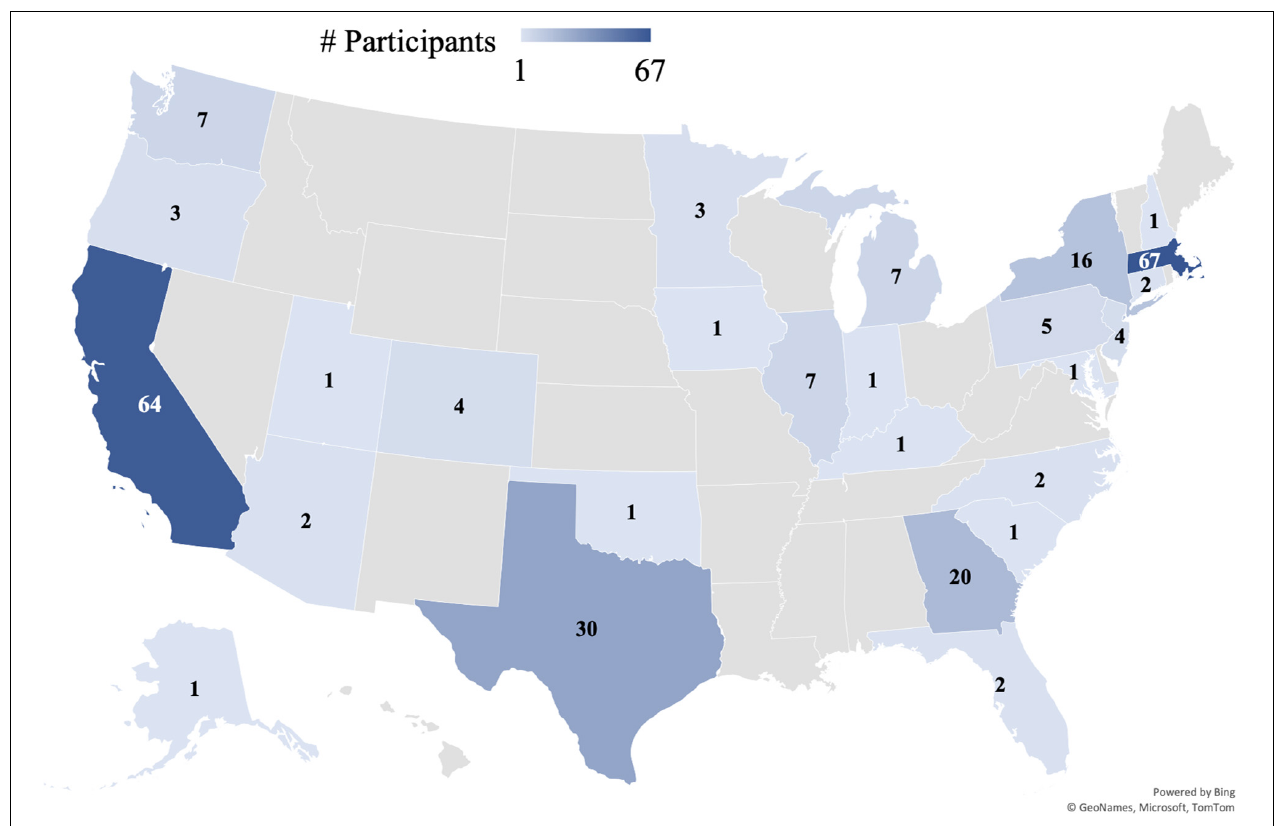
FIGURE 2 | Map of participants by state. Map shows number of participants per state that were sorted into one of the three intervention groups ( N = 255). Not shown: 1 participant from